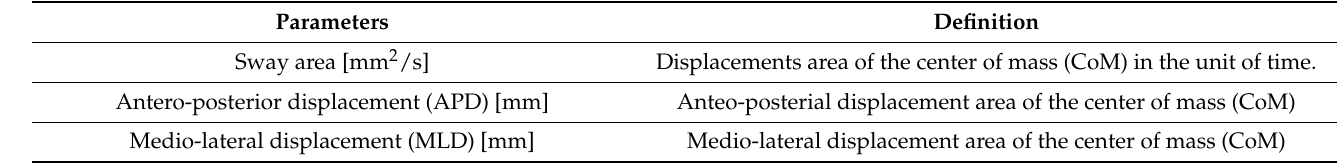
Table 2. Definition of the parameters used in the assessment of balance.